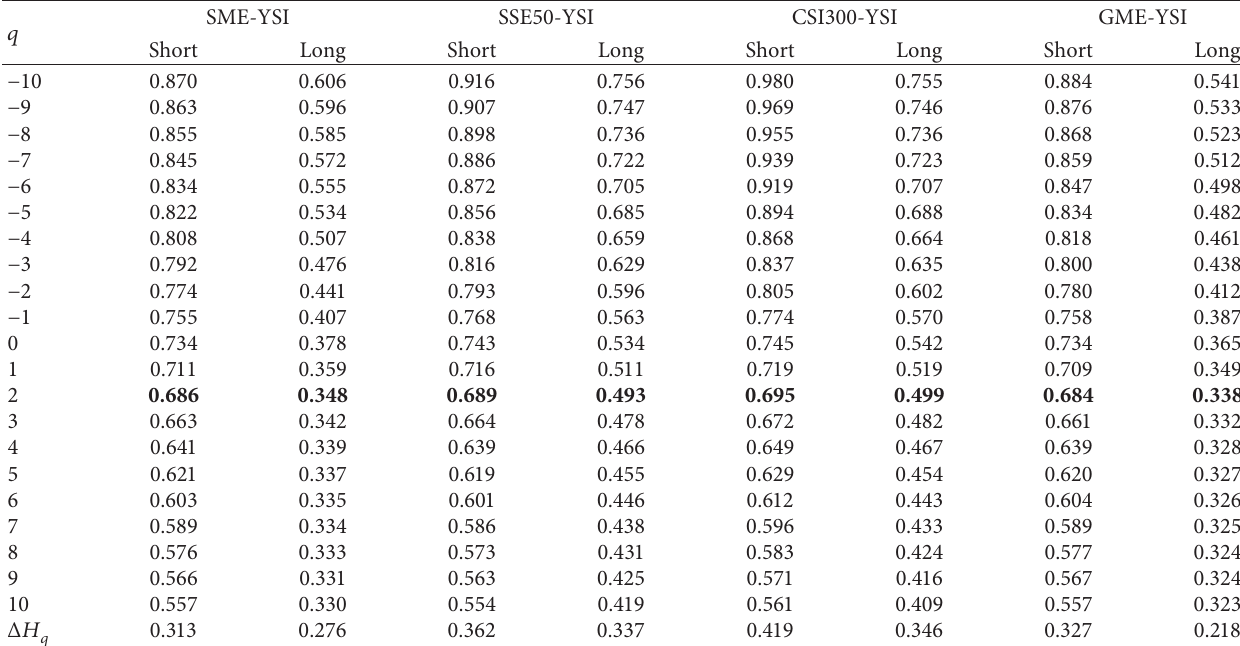
Table 8: Results of the short-term and long-term scaling exponents for Chinese stock market